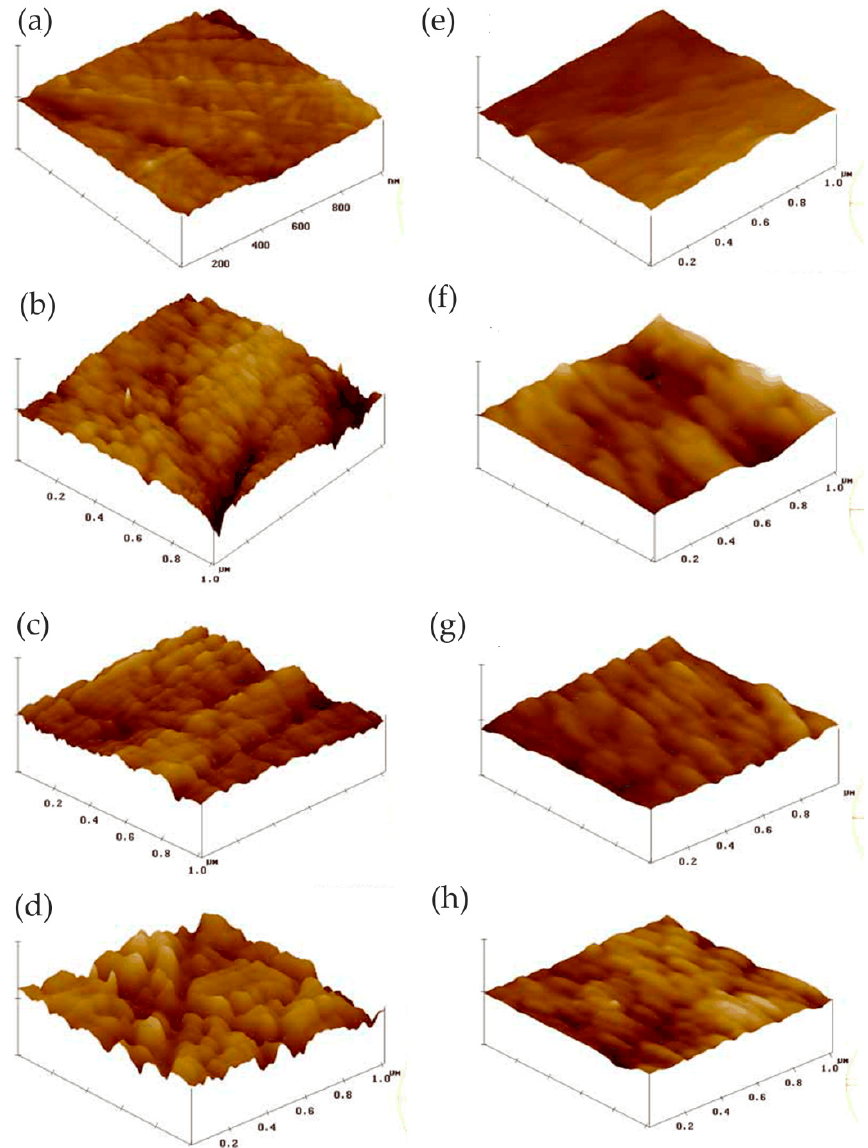
Figure 35. Morphological changes of copper in solution of 0.1 M Na 2 SO 4 ( a – d ) and 0.1 M Na 2 SO 4 + 0.5 mM dibenzylsulfoxide (DBSO) ( e – h ), at different times: ( a , e ) 0 min; ( b , f ) 15 min; ( c , g ) 30 min; ( d , h ) 45 min. Reprinted with permission from Reference [79]; copyright 1998 Springer.